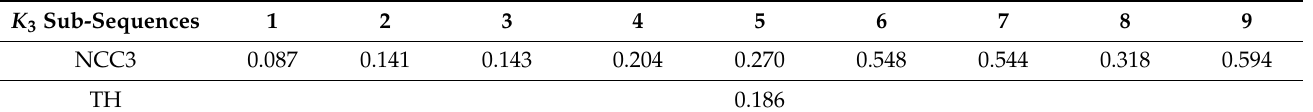
Table 2. The correlation coefficient NCC 3 and the standard deviation TH for sub-sequences of K 3